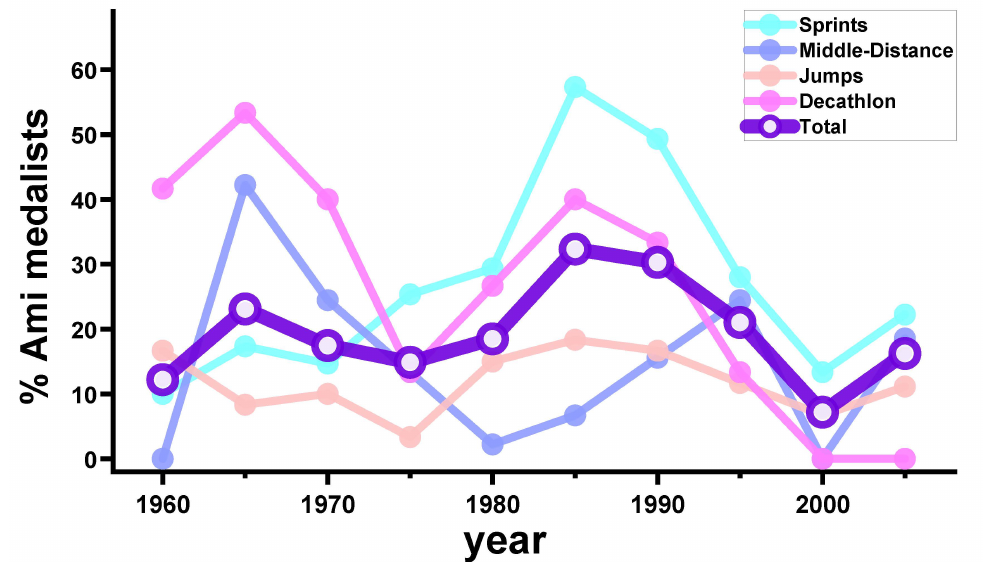
Figure 2. The percentages of Ami medalists (top-three winners) in Taiwanese national track-and- field games from 1957 to 2005 are disproportional to the mere 0.6–0.8% population of Ami in Taiwan [41]. Each datum point is the percentage of Ami male medalists among all male winners in a 5-year timeframe (i.e., the datum point at 2000 represents the number from 5-year compila- tion from 1996 to 2000). The “Sprints” section includes 5 types of games—100 m, 200 m, 400 m, 100 m hurdles, and 400 m hurdles. For each datum point in the “Sprints” section, the denomina- tor is 75 (3 medalists/type × 5 types × 5 years). The same rationale applied for the calculation of other sections specified in the graph. The “Middle-Distance” section includes 800 m, 1500 m, and 3000 m steeplechase. The “Jumps” section includes long jump, triple jump, high jump, and pole vault. The “Total” encompasses statistics from the four sections—Sprints, Middle-Distance, Jumps, and